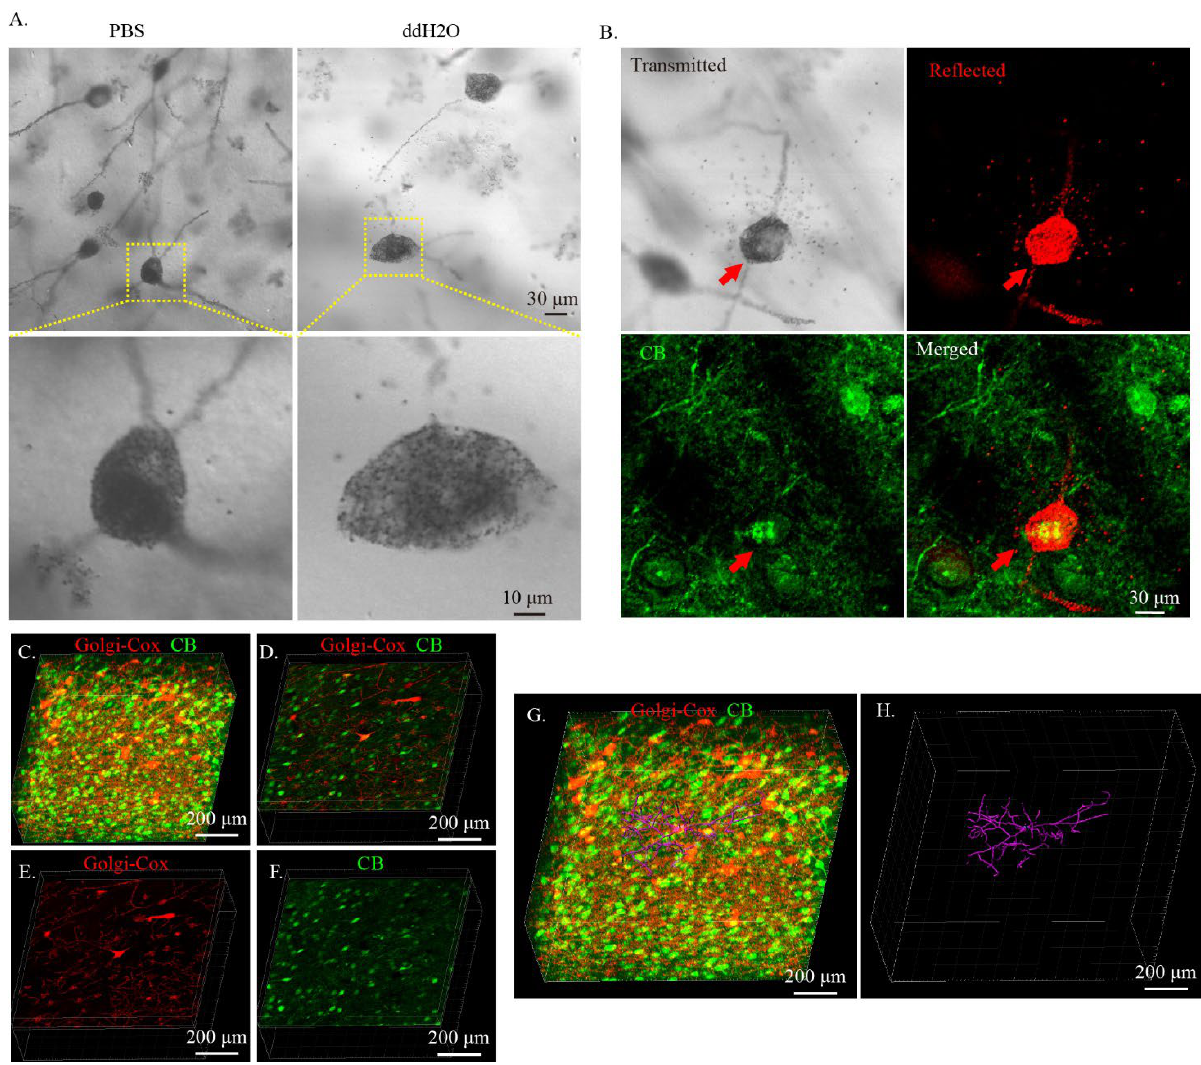
Figure 5. Reconstruction of specific neuron morphology in cleared Golgi-Cox-stained tissue by combining expansion and immunostaining. ( A ) Expansion of cleared Golgi-stained tissue with DI water. Cleared Golgi-stained tissues were incubated in either PBS or DI water. The image was obtained using transmitted light with confocal microscopy. ( B ) Imaging a single neuron labeled with Golgi-Cox stain and immunostaining (immunostained with calbindin antibody). The “transmitted” panel was obtained using transmitted light, The “reflected” panel was obtained using the confocal reflective mode, and the “CB” panel was obtained using the standard confocal imaging mode. ( C – H ) Three-dimensional reconstruction of a single neuron morphology labeled with both Golgi-stain and immunostain. The Golgi-Cox-stained signal was obtained using the confocal reflective mode of the confocal microscopy and the immunostained signal was obtained using standard confocal imaging mode. ( C ) Three-dimensional rendering showing the 3D immunostain of Golgi-Cox-stained tissue with CB. ( D ) Sectional image from ( C ) showing the colocation of Golgi-stained neuron with CB-immunopositive neuron. ( E , F ) The Golgi-stained channel and CB-stained channel of ( D ). ( G ) Reconstruction of the CB-immunopositive neuron morphology using the Golgi-Cox stain. ( H ) Reconstructed CB-immunopositive neuron. The reconstruction was performed using the FilamentTracer function of Imaris software and the neural fibers were tracked automatically by the